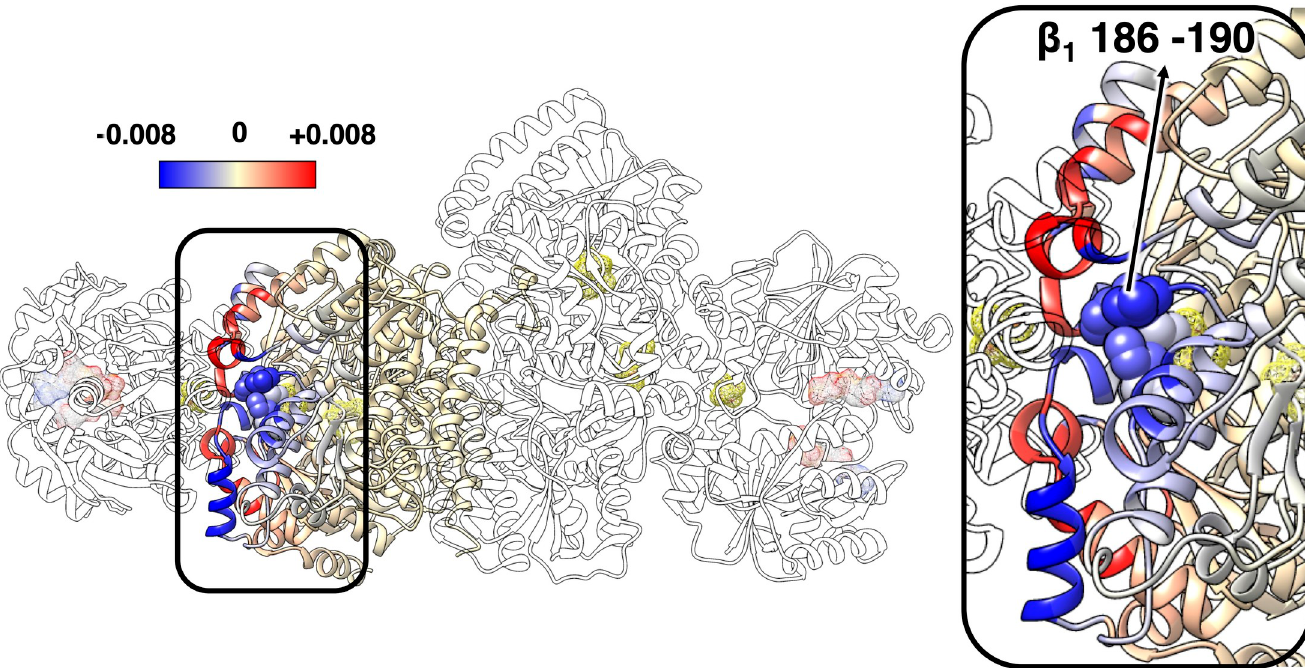
Fig 5. Change in M between residues in α 1 β 1 to any residue in Fe 1 upon ATP hydrolysis. The change is shown as largest deviation of M in the ADP-bound complex relative to the ATP-bound complex, either positive (red) or negative (blue) following the same projection scheme discussed in Fig 4. The Fe 1 , Fe 2 , α 2 β 2 proteins are shown in white. The ATP analogues, [4Fe-4S] clusters, P-clusters, and FeMo-co are shown in mesh surface. Residues 186–190 in β 1 are highlighted in spheres and residues 119–120 in α 1 are indicated by arrow. Residues at Fe protein/MoFe protein interface with large deviation upon ATP hydrolysis appear in dark red or dark blue. For clarity of representation only the change in one half of the MoFe protein is shown.